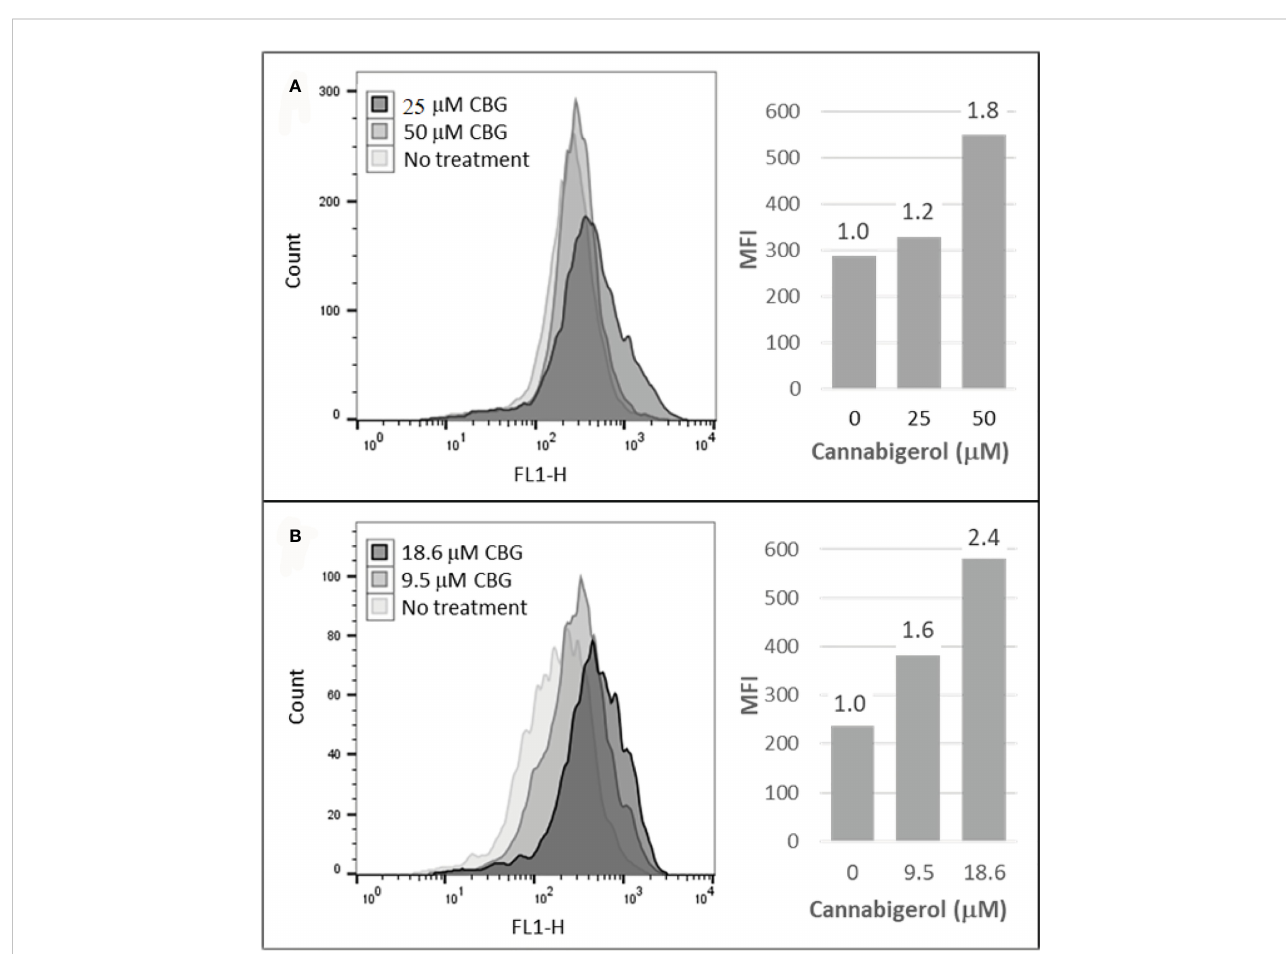
FIGURE 3 Cannabigerol induces MHC-I expression in human and mouse metastatic carcinomas. (A) The human colorectal cancer cell line, COLO 205 was treated with 25 and 50 m M CBG and (B) the mouse breast cancer cell line 4T1 was treated with 9.5 and 18.6 m M CBG. In both experiments, MHC-I was measured by fl ow cytometry after 48 hr. Left panel: fl ow cytometry histogram. Right panel: mean fl uorescent intensities (MFI) for each treatment condition ; fold increase in MHC-I expression (treatment MFI/no treatment MFI) is indicated above each bar. These data are representative of three independent experiments.